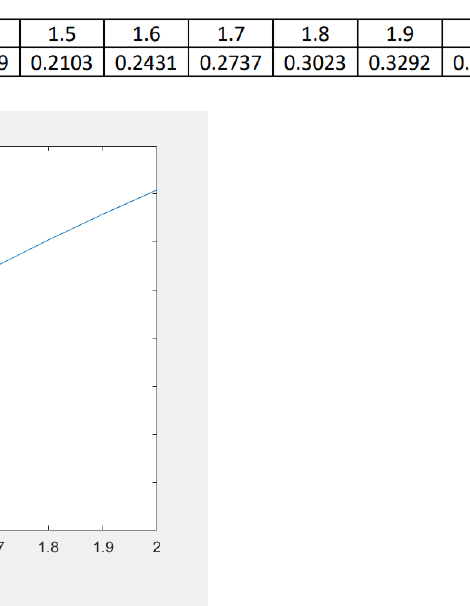
Figure 1. Connection between impulse of derivative δ and the maximal possible distance between points of impulses τ .